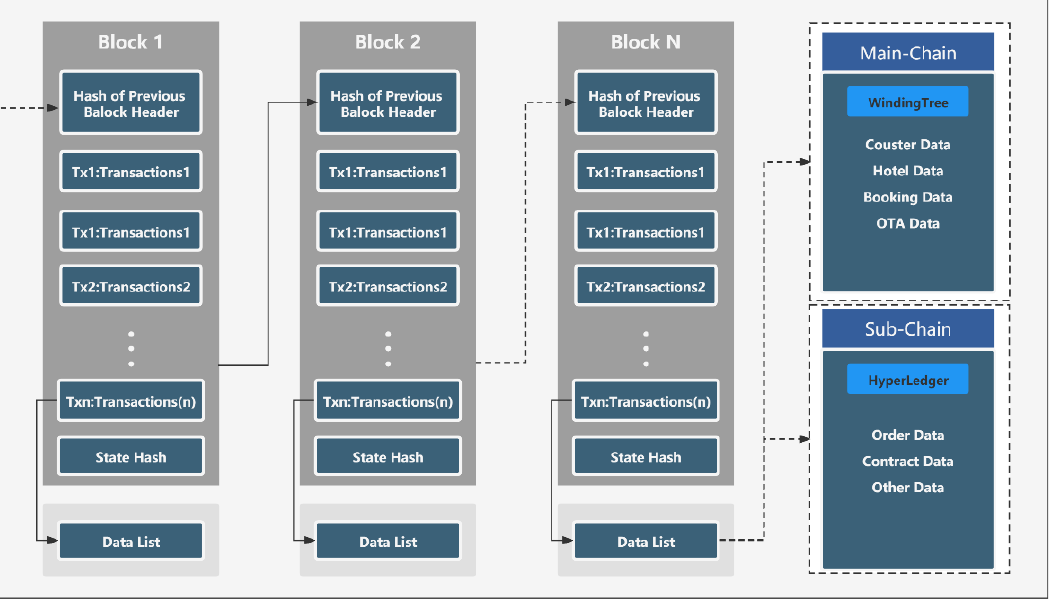
Figure 16. Block transaction information and structure.